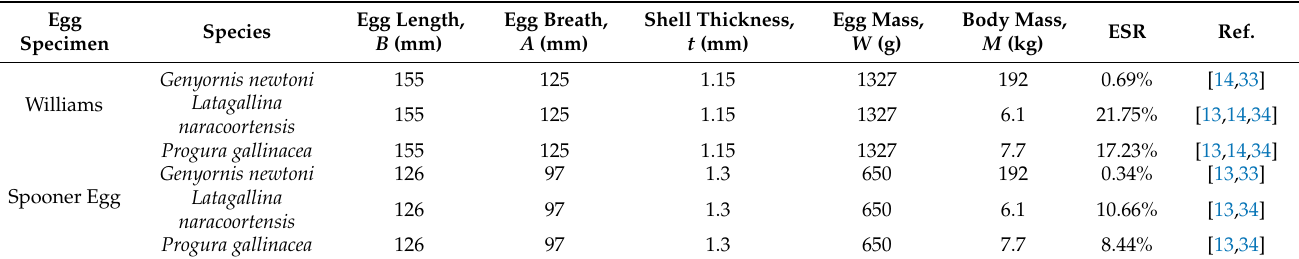
Table 2. Comparison of two known eggs (with measured parameters) with possible source taxa (with estimated body mass) to generate ESR. These values were used in the FEA simulations. ESR: egg size ratio (W/M). Egg